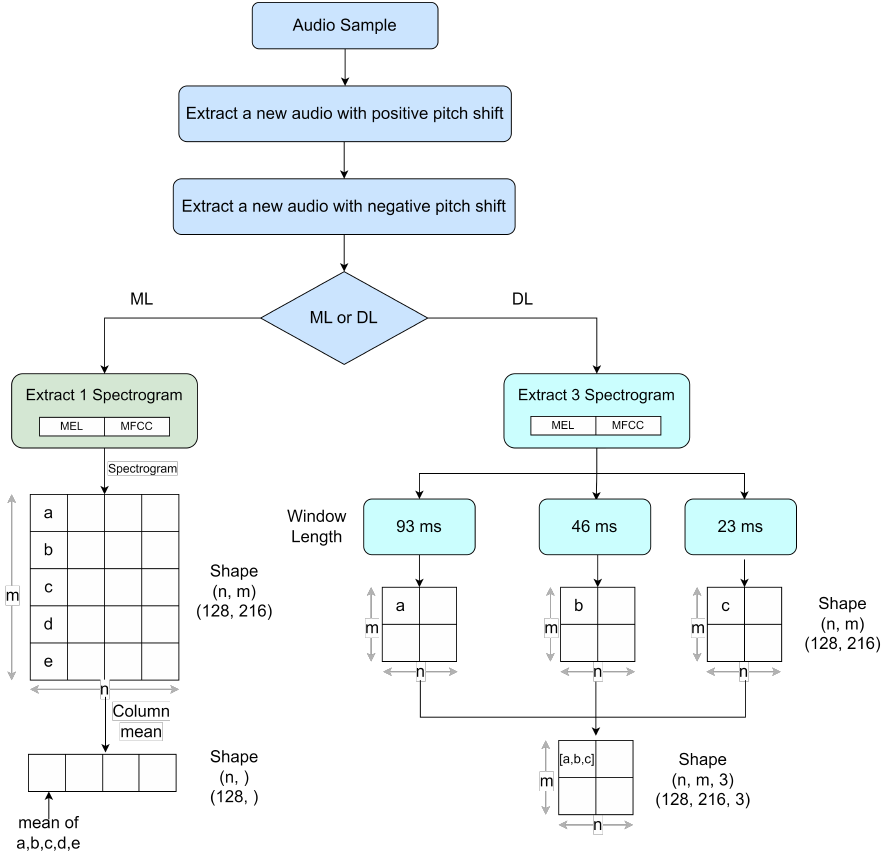
Figure 8. Feature preparation